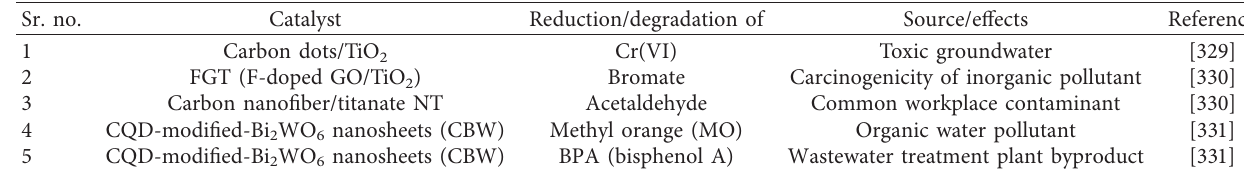
Table 14: Catalysts and its degrading effect on